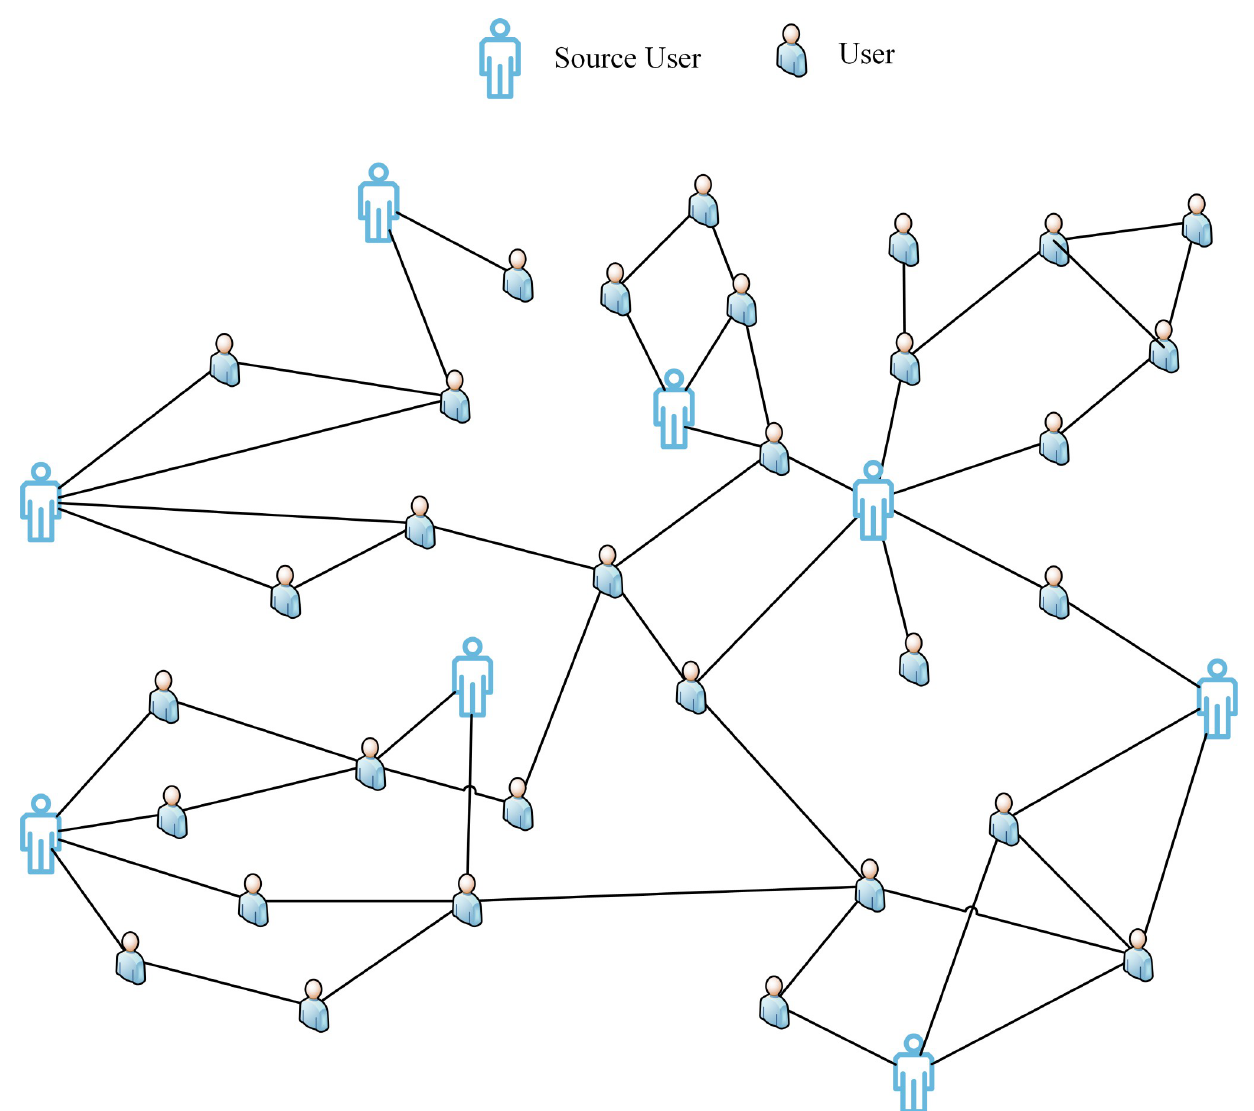
Fig 1. Twitter global graph of network